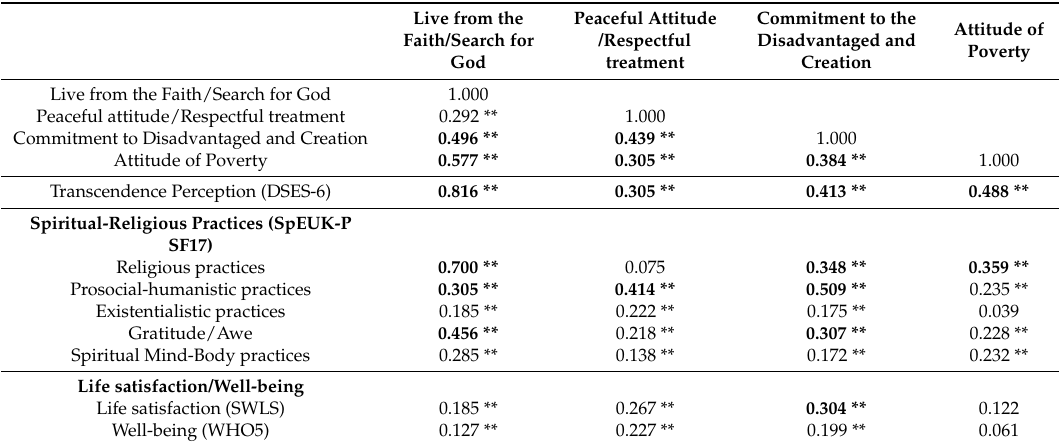
Table 4. Correlation